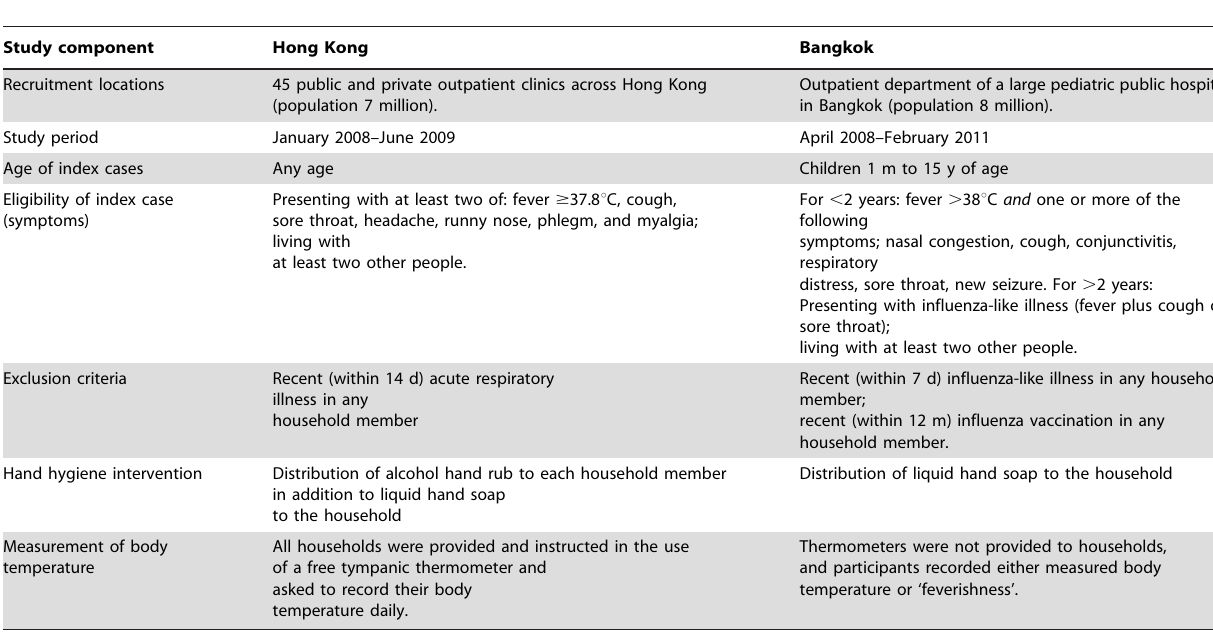
Table 1. Minor differences between the study designs in Hong Kong and